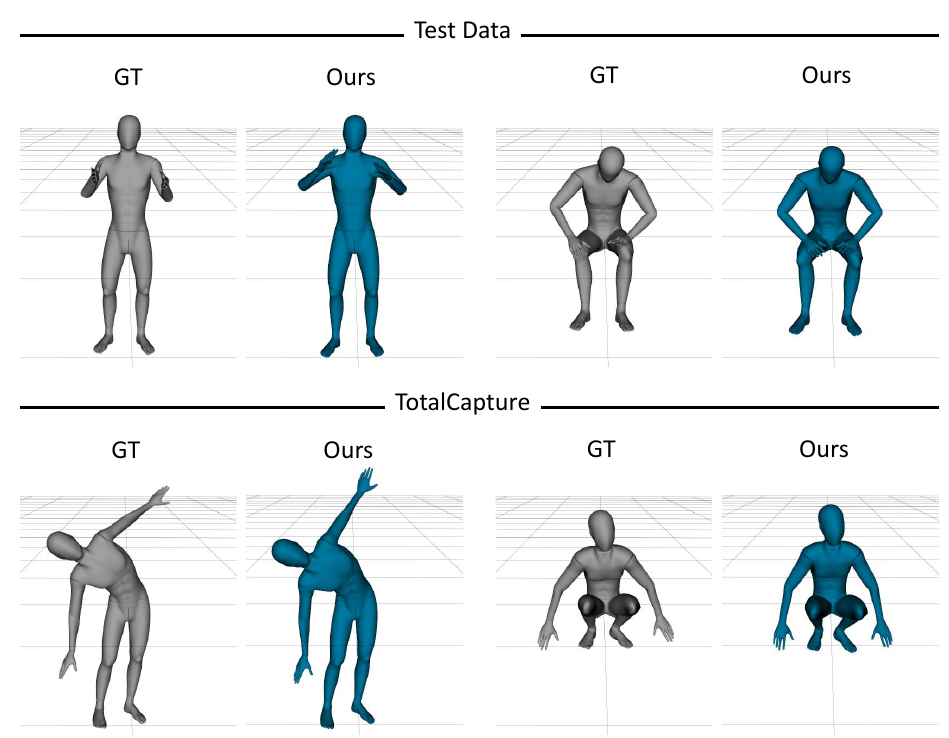
Figure 10. Example results using our mocap data and TotalCapture